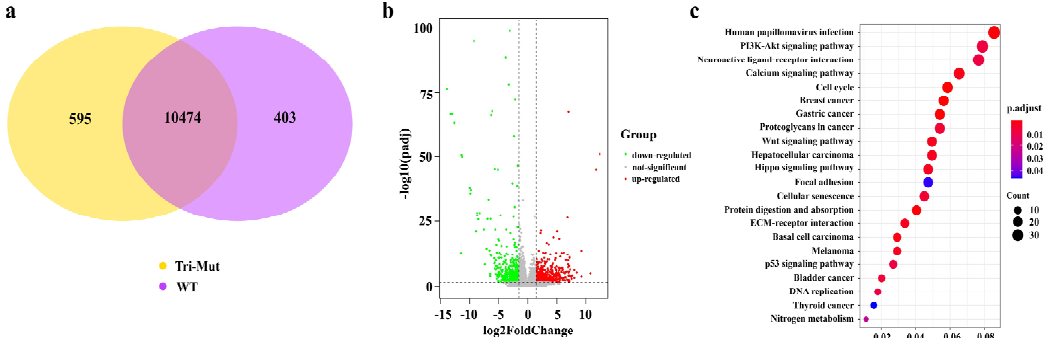
Figure 6. Venn diagram, volcano plot, and KEGG enrichment of DEGs between Tri-Mut and WT cells. ( a ) The Venn diagram shows the number of genes differentially expressed within groups. ( b ) Volcano map of differentially expressed genes between Tri-Mut cells and WT cells. The x -axis represents the value of log2 (fold change), and the y -axis shows the value of − 1og10 (padj). ( c ) Statistics of KEGG pathway enrichment. The x -axis shows the enrichment factor; the y -axis lists KEGG pathways. The color of the dot denotes p .adjust, and the size of dots represents the number of DEGs mapped to the reference pathway. R package VennDiagram (1.6.19) was used to draw the Venn diagram of the number of DEGs in Tri-Mut and WT; R package ggplot2 (3.3.1) was used to draw the volcano map of analysis of DEGs and the bubble diagram of KEGG enrichment analysis.